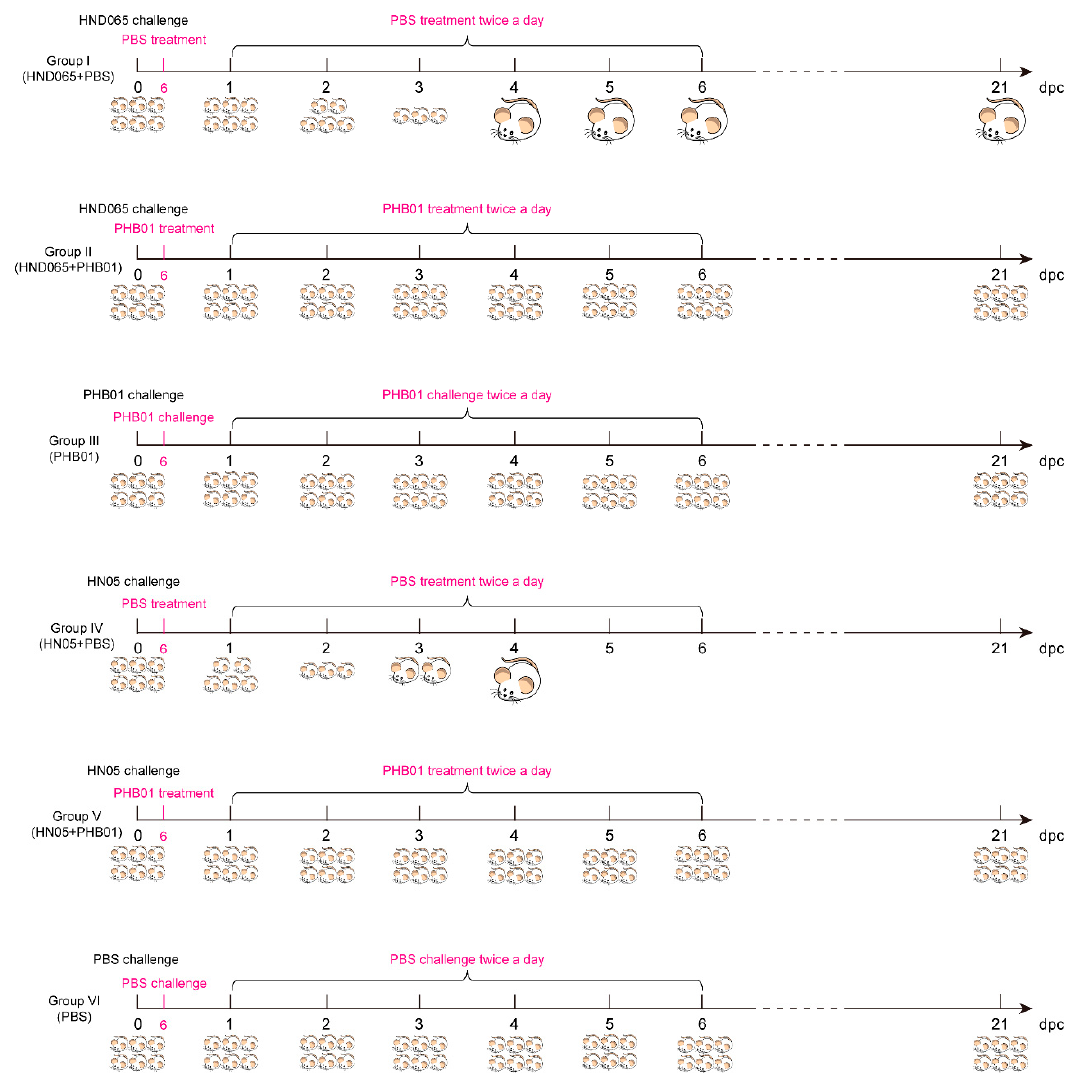
Figure 1. Experimental scheme for the evaluation of PHB01 treatment efficacy in mice infected with P. multocida type D. Each of the mice in the P. multocida -challenged groups were given a treatment